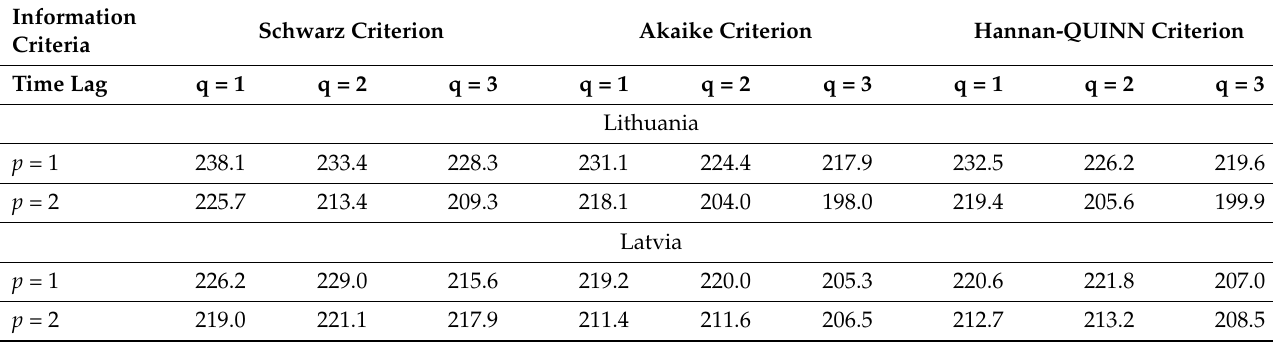
Table A1. Information criteria for best time lag